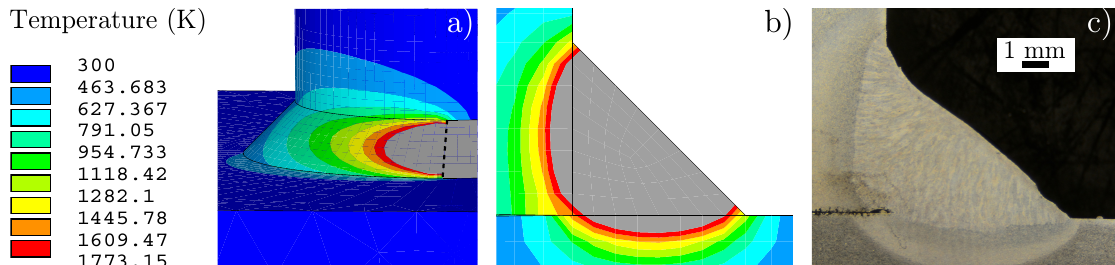
Figure 8. Heat flux model: Overview of the thermal solution ( a ), FE-model cross section of the weld seam ( b ), and real cross section of the weld seam ( c ).